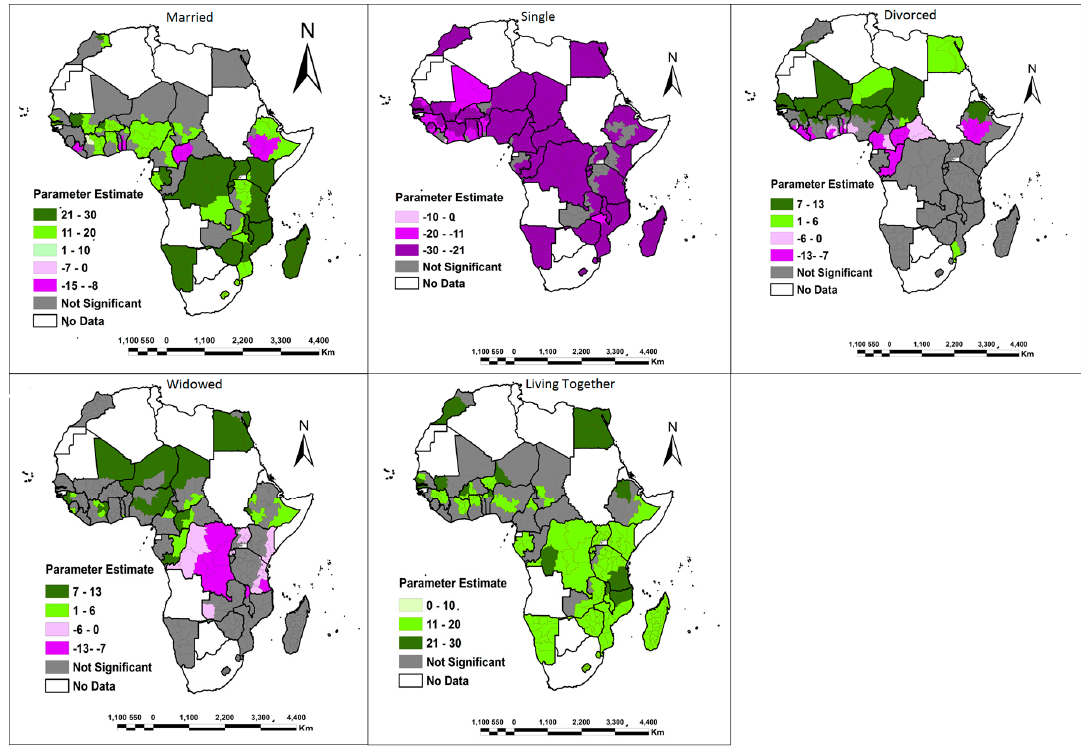
Figure 3. Spatial distribution and significance of marital status on women’s access to own land.